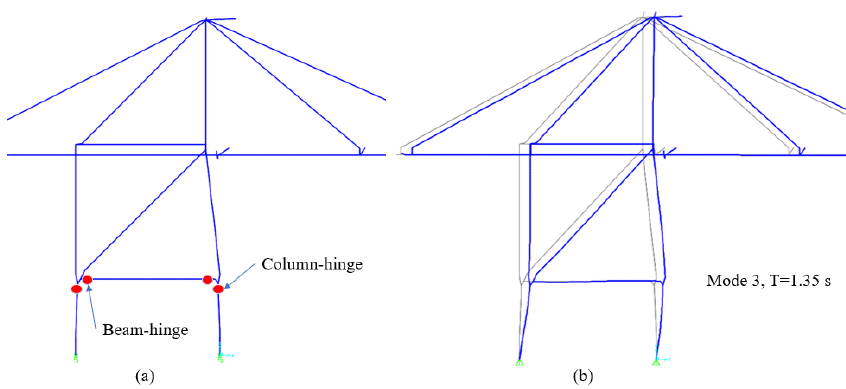
Figure 3. ( a ) Plastic hinge; ( b ) portal sway at the fundamental period T = 1.35